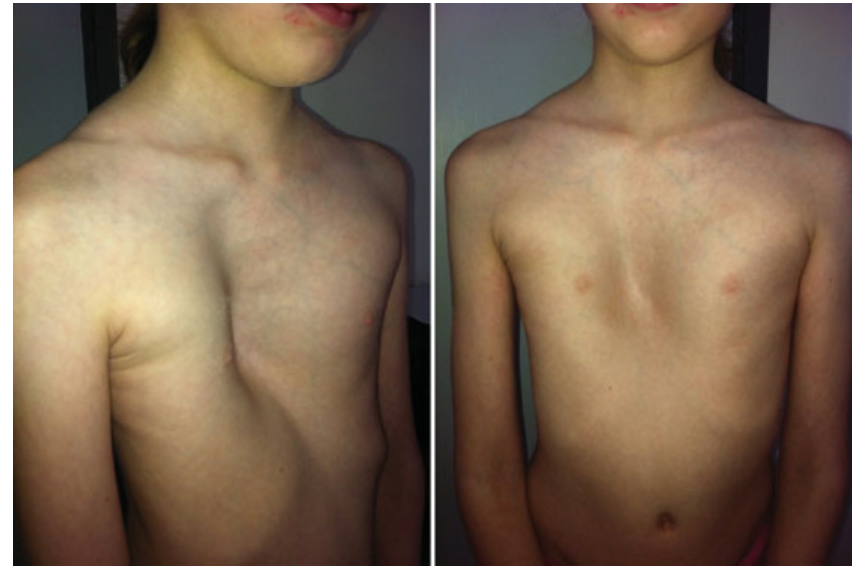
Fig. 1 Patient prior to surgical intervention. Patient is an 8-year-old girl; image shows lateral and anteroposterior image at the time of the fi rst outpatient clinic visit. An asymmetrical severe pectus excavatum is observed.